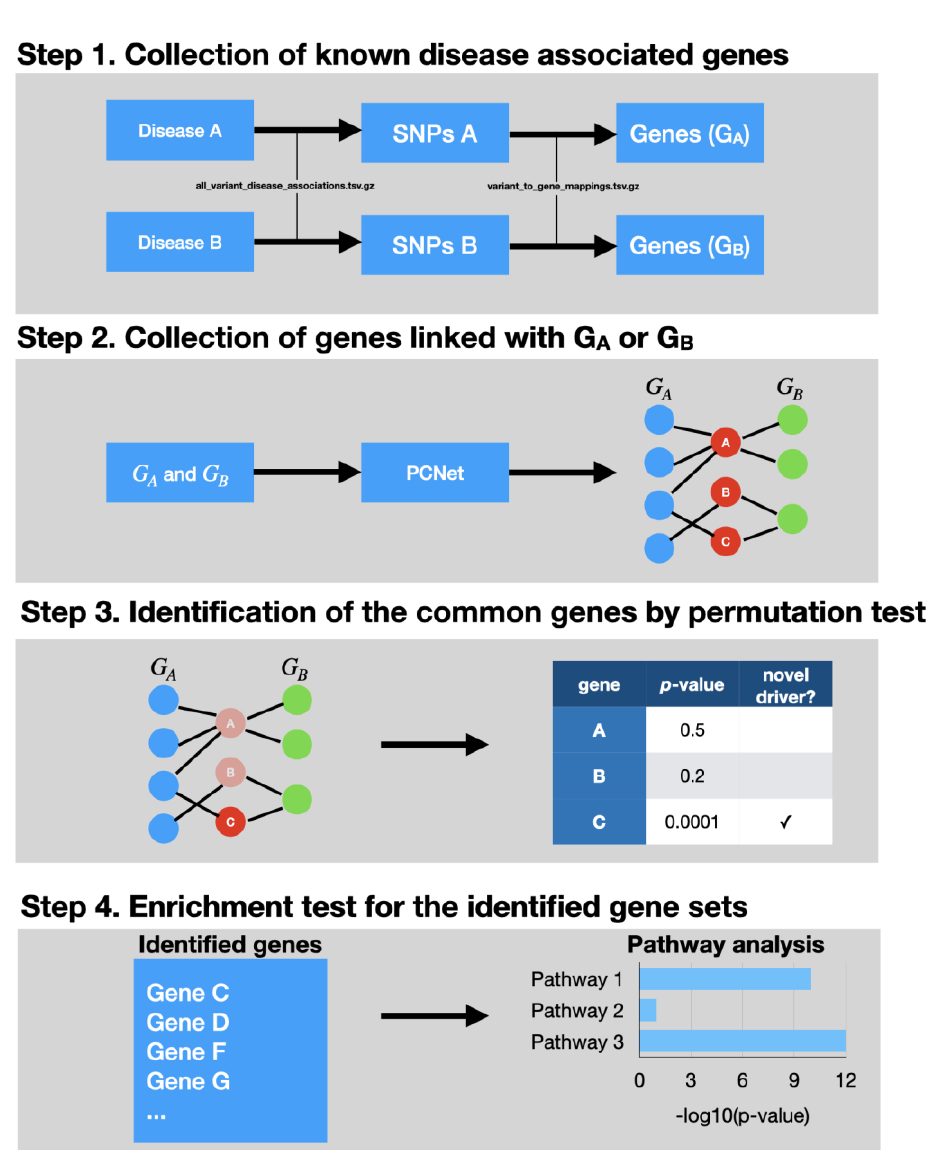
Figure 2. This figure demonstrates the network-based identification of common driver genes (NICD) workflow, with the specific data sets and programs used construct the algorithm. In the topmost panel, the diseases and genes are identified. These are then placed into PCNet, which is a composite gene network focused on common gene identification for query. In order to remove those genes which maybe randomly associated, a permutation assay with Benjamini–Hoichberg correction is done to ensure that proper candidates demonstrate strength of association. In the bottom-most panel, an enrichment assay is done on the candidate genes which tests their association with canonical pathways.